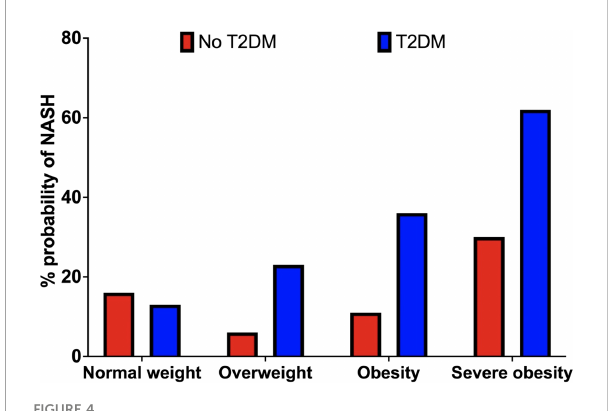
FIGURE 4 Probability of NASH (%) by obesity category (BMI) in the non-T2D (red) and T2D (blue) cohorts.